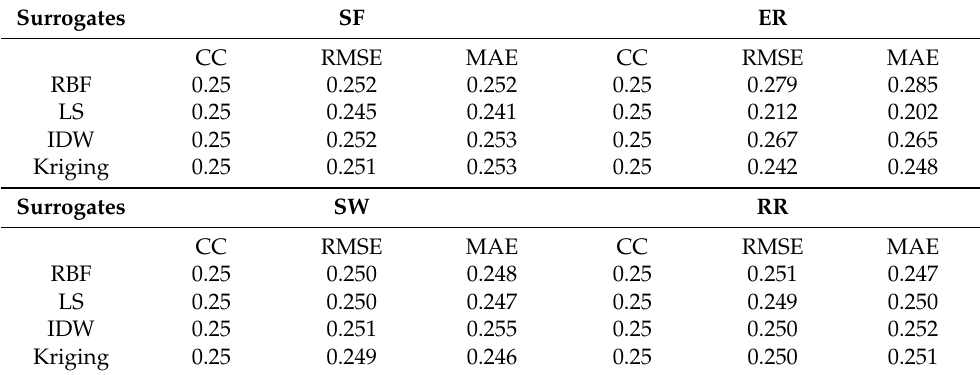
Table 1. Model characteristics of the four types of networks.